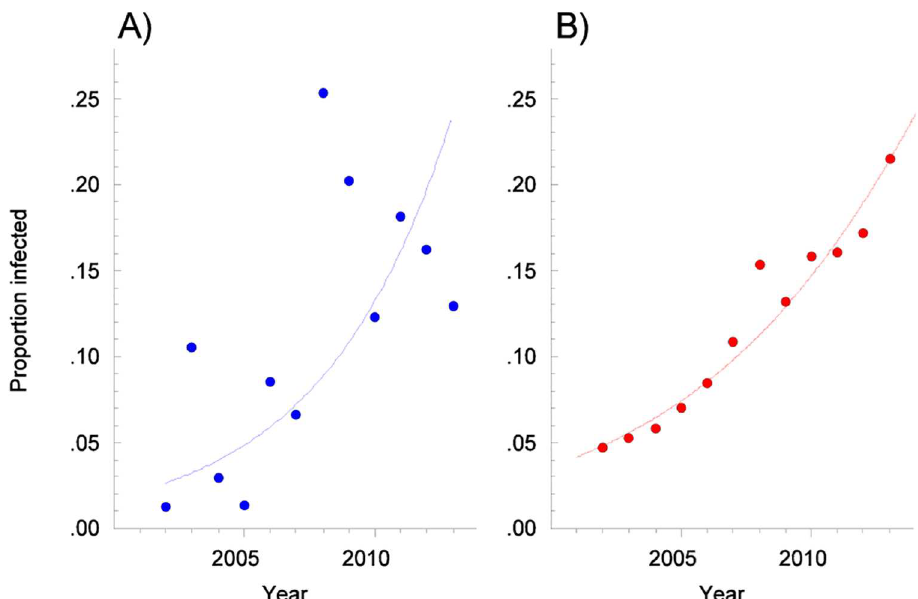
Fig 2. A) Proportionof grey seals ( Halichoerus grypus ) from the Baltic coast of Sweden infected with Pseudamphistomum truncatum per year from 2002 to 2013 unadjusted for explanatoryvariables.The proportion of infected seals increasessignificantly over time (p < 0.01, log-linear regression).B) Predicted proportion of grey seals from the Baltic coast of Sweden infected with P . truncatum per year from 2002 to 2013, adjusted proportions using an average of 8 years of age and observed mean values for sex and cause of death. This reduces the variance in the logistic model (p < 0.001, full logistic model compared to intercept only).